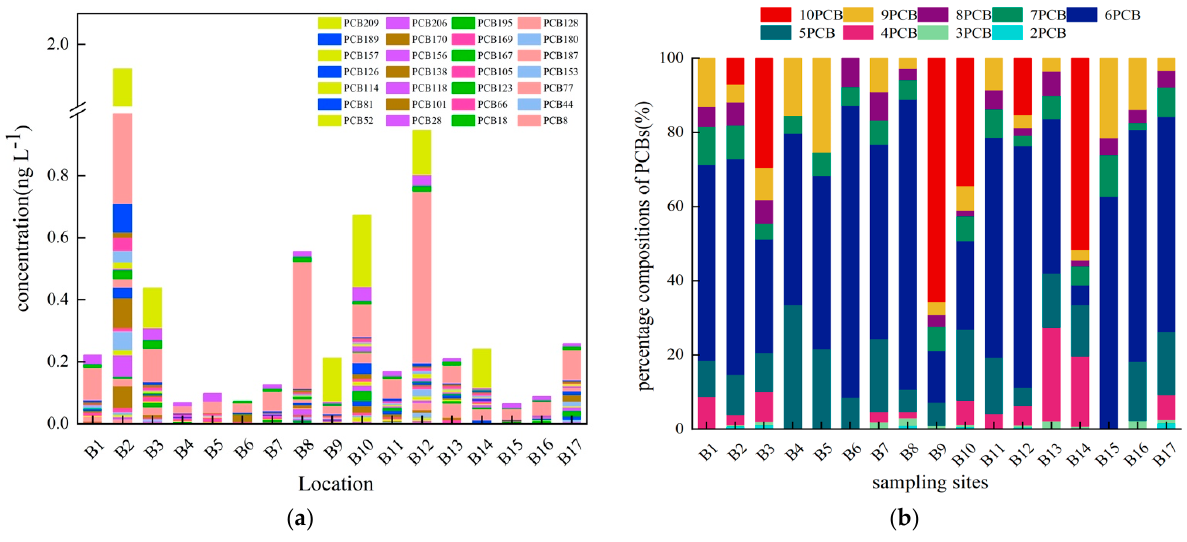
Figure 2. ( a ) PCBs concentrations in all sampling sites. ( b ) PCBs homolog profiles (i.e., relative contribution to total PCBs in %) in all sampling sites. Table 1. Concentrations of PCBs in waterbodies in different regions.